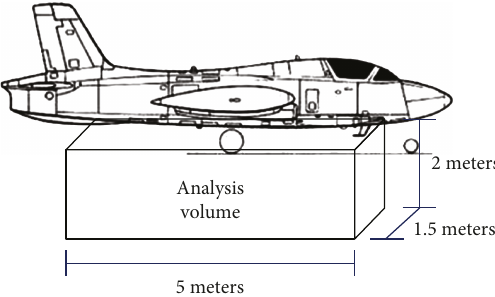
Figure 1: Example of the spatial volume considered in the fi eld of view of the camera.